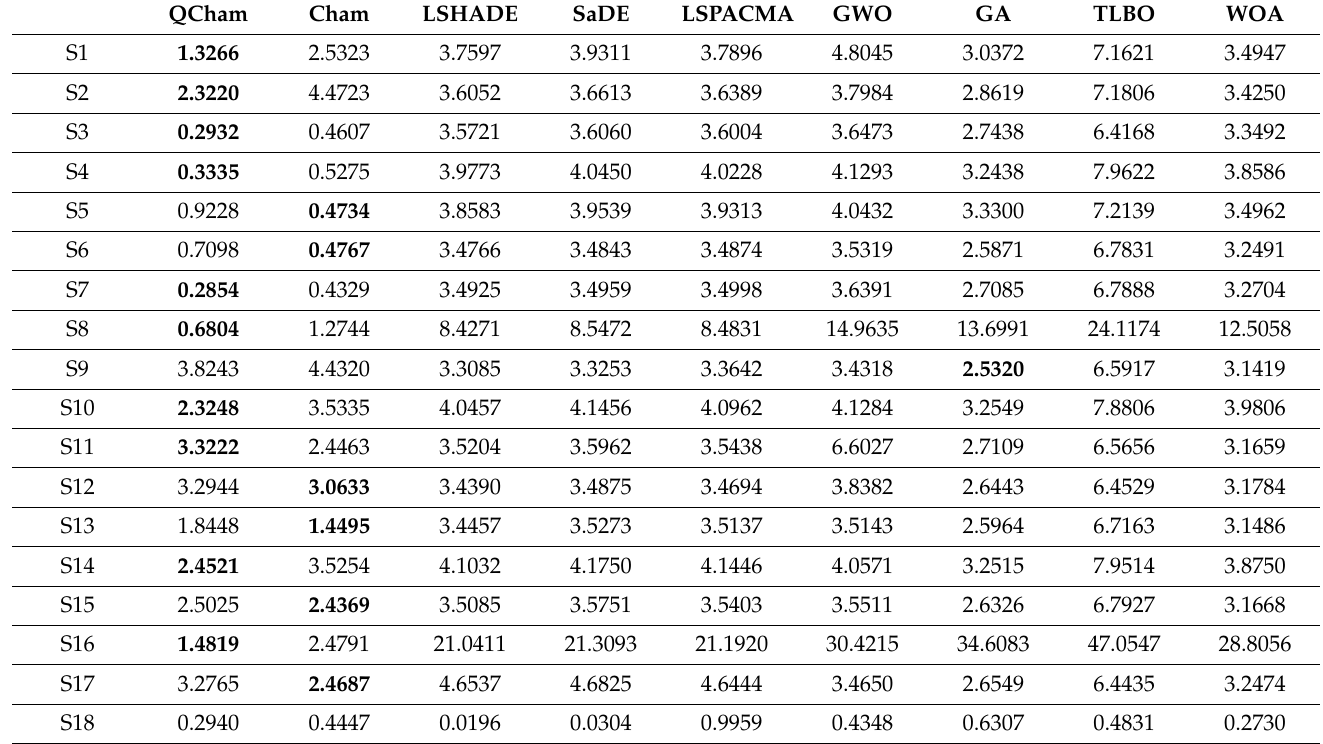
Table 8. CPU(s) time of the QCham and other methods.